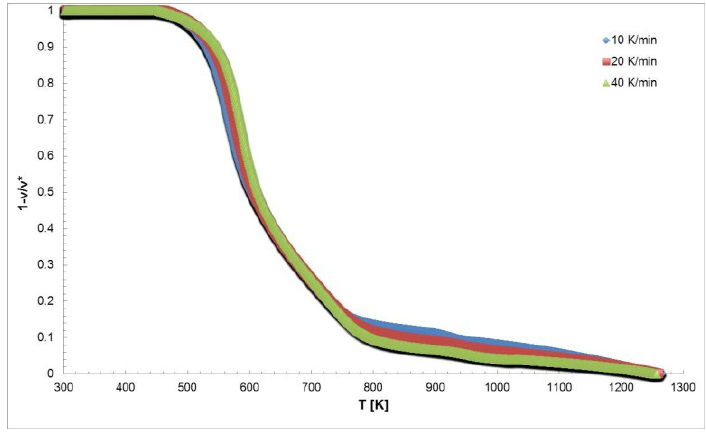
Figure 1. TG curves of the Chlorella vulgaris microalgae at different heating